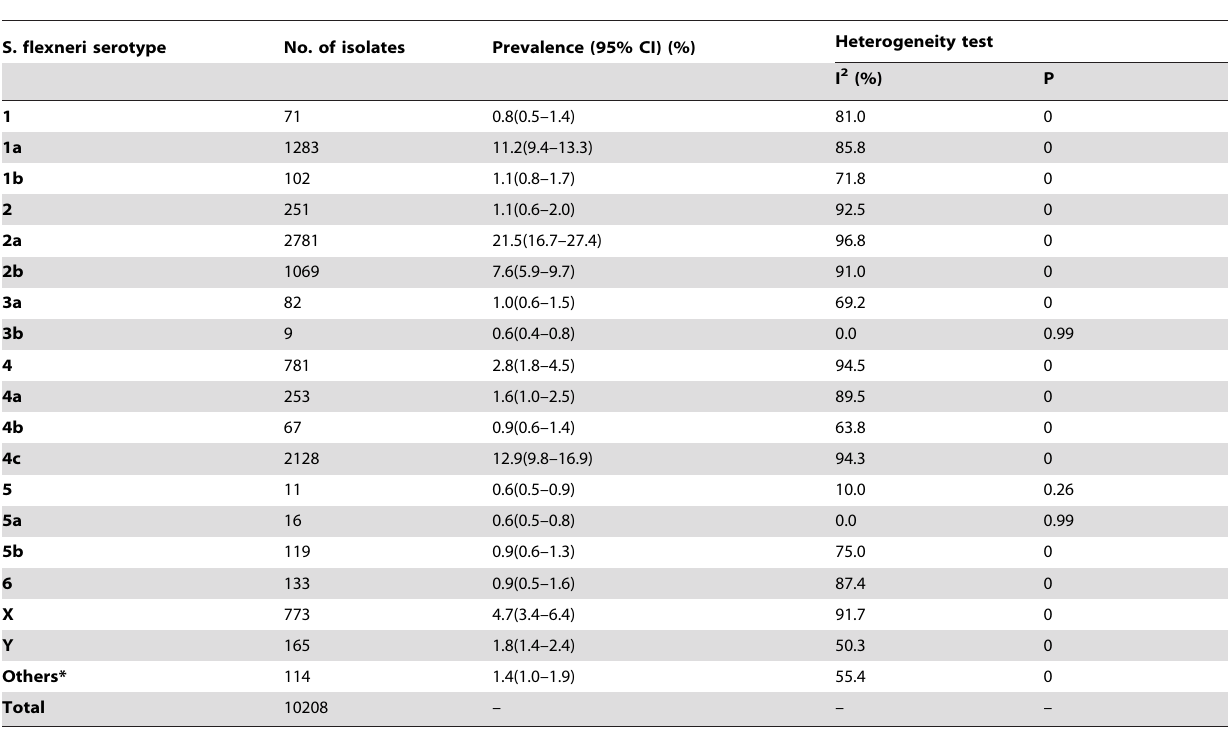
Table 2. Distribution of S. flexneri serotypes in mainland China, 2001–2010 (63 studies included).